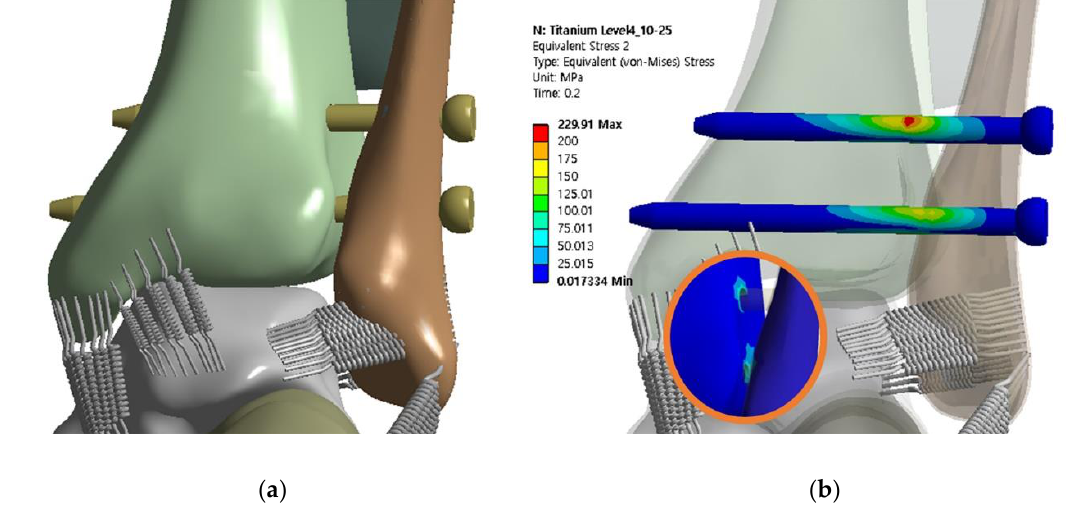
Figure 15. Finite element model and distribution of maximum equivalent stress with screws inserted at levels of 10 and 25 mm: ( a ) finite element model of syndesmotic fixation with double screws, and ( b ) maximum equivalent stresses of the screws and adjacent bone.